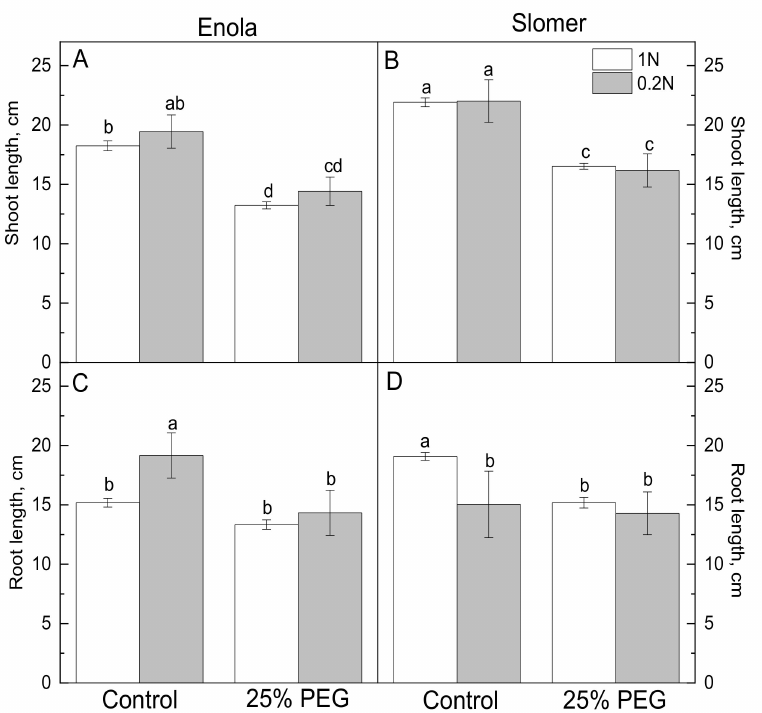
Figure 1. Growth parameters assessed by shoot ( A , B ) and root ( C , D ) length of two wheat varieties (Enola and Slomer) supplied with optimal (1 N) or low (0.2 N) nitrogen in the medium and subjected to osmotic stress with 25% PEG. Different letters represent significant differences at p < 0.05 ( n = 10).